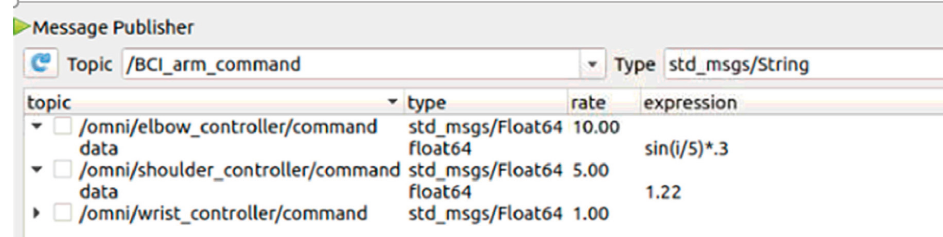
Figure 16: Message publisher used for tuning of joint